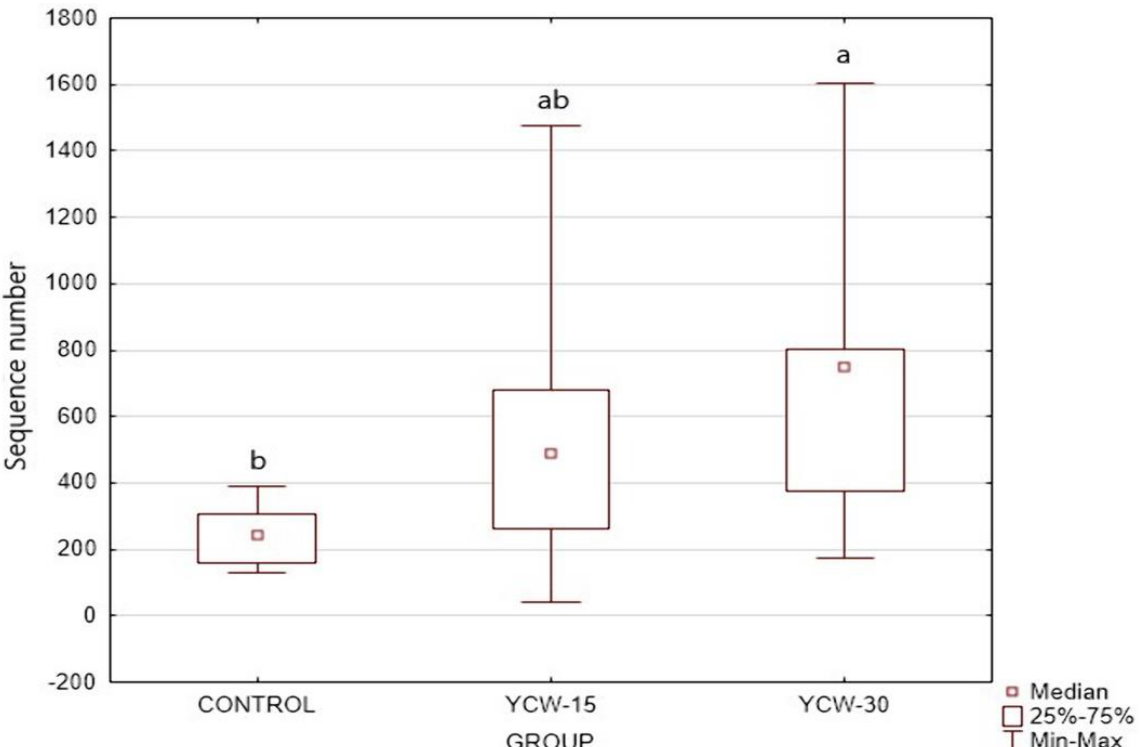
Figure 7. Median differences (absolute values) among treatments in the metabolic pathway CENTFERM-PWY. a,b Boxplots with the same letters are similar at p ≤ 0.1.